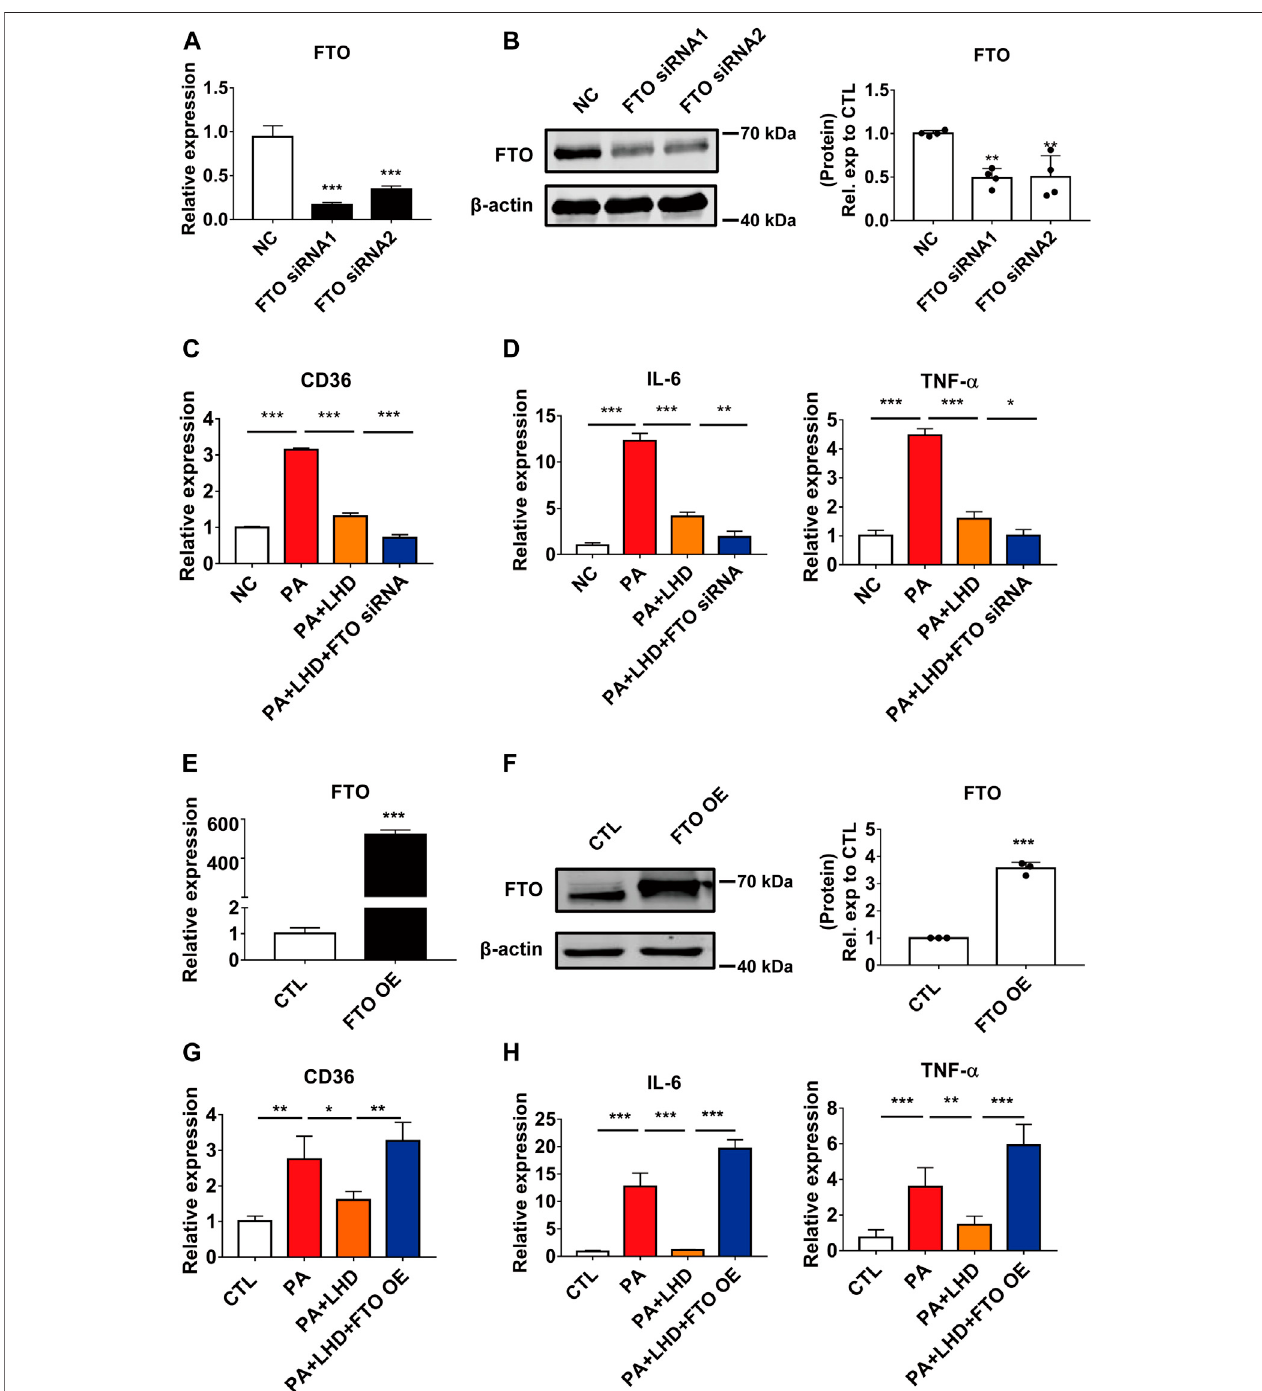
FIGURE5| FTOaltersCD36expression. (A,B) Silencingef fi ciencyofFTO. (A) qRT-PCRanalysisoftheeffectoftransfectionofFTOsiRNAafter24 hinAC16cells. *** p < 0.001,compared withtheNC groups, n (cid:1) 3. (B) Western blottinganalysisoftheeffectoftransfection ofFTO siRNAafter 48 hinAC16 cells.** p < 0.01,compared withtheNCgroup, n (cid:1) 4. (C) EffectofFTOlossoffunctionandLHDco-treatmentonCD36expressioninAC16cells.*** p < 0.001, n (cid:1) 3. (D) EffectofFTOlossoffunction andLHDco-treatmentonIL-6andTNF- α expressioninAC16cells.* p < 0.05,** p < 0.01,*** p < 0.001, n (cid:1) 3. (E,F) Ef fi ciencyofFTOoverexpression. (E) Expression of FTO mRNA after FTO overexpression for 24 h in AC16 cells. (F) Expression of FTO protein after FTO overexpression for 48 h in AC16 cells. *** p < 0.001, compared with the CTL group, n (cid:1) 3. (G) Effect of FTO overexpression on the expression of CD36 in PA-treated AC16 cells. * p < 0.05, ** p < 0.01, n (cid:1) 3. (H) Effect of FTO overexpression on the expression of IL-6 and TNF- α in PA-treated AC16 cells. ** p < 0.01, *** p < 0.001, n (cid:1) 3.